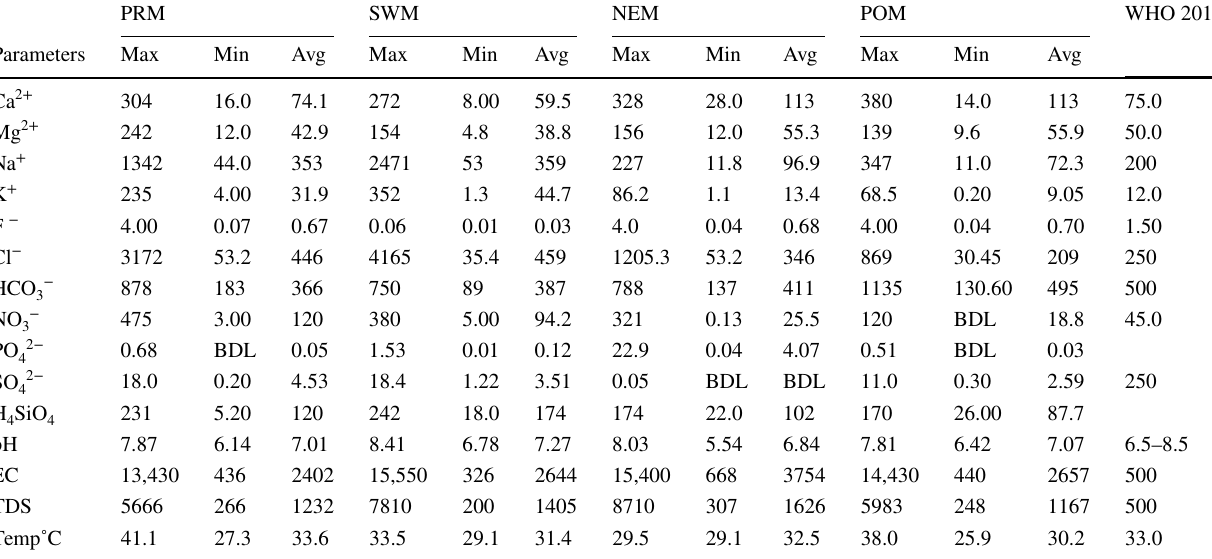
Table 2 Maximum, Minimum and Average value of the chemical constituents in groundwater representing all four seasons (All values in mg1 −1 except EC in µs/cm −1 and